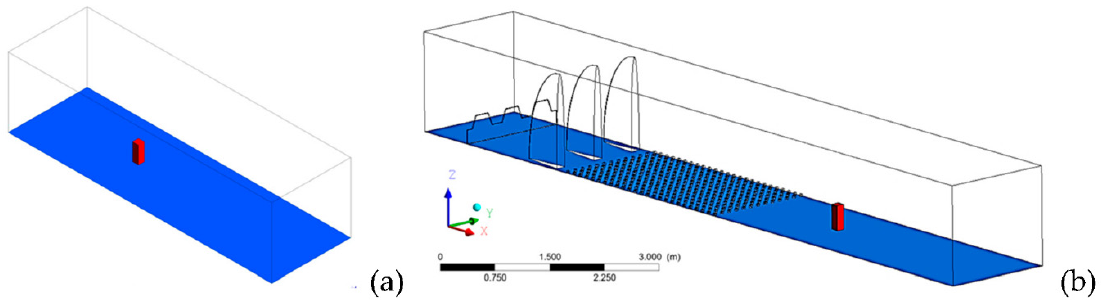
Figure 3. ( a ) Steady and ( b ) fluctuating inlet domains for LES.